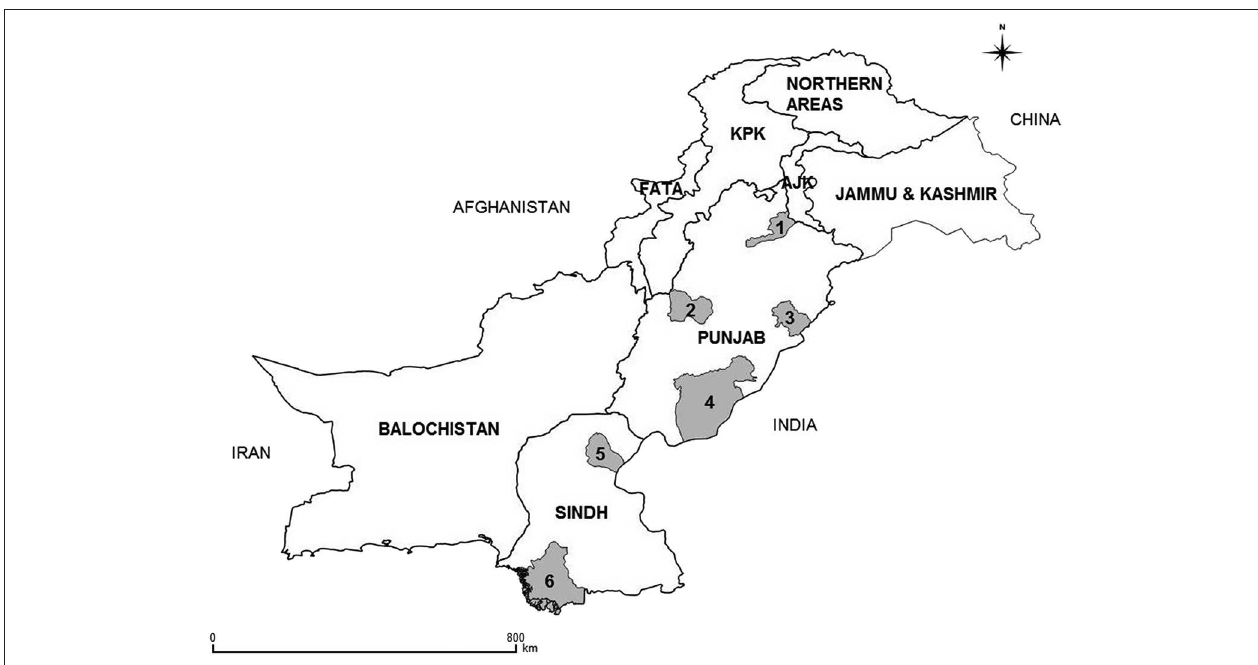
FIGURE 1 | Map of Pakistan showing the locations of districts (gray-colored areas) included in the study. The names of the districts are Jhelum (1), Layyah (2), Okara (3), Bahawalpur (4), Sukkur (5), and Thatta (6). The map was created using QGIS v.